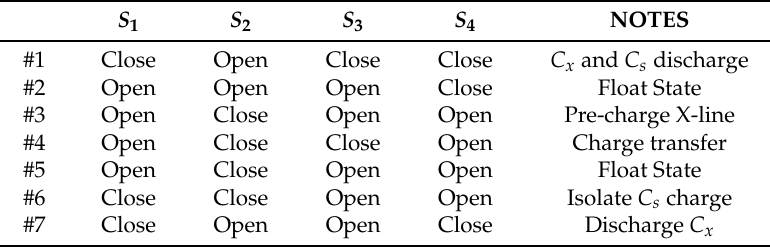
Table 1. Sequence diagram of the mutual capacitance sensor circuit.